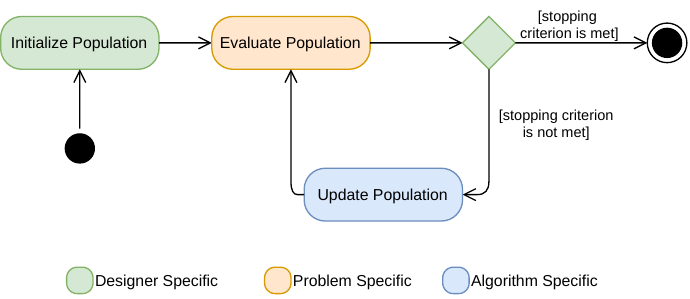
Figure 2. Activity sequence in swarm-based